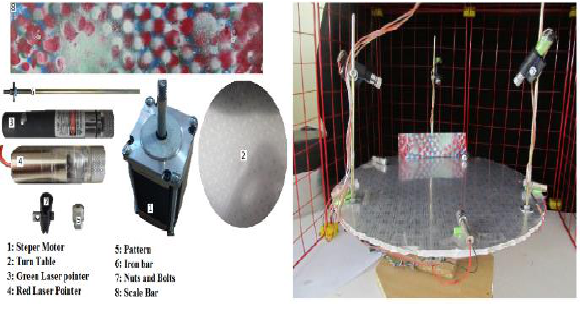
Figure1- general components of